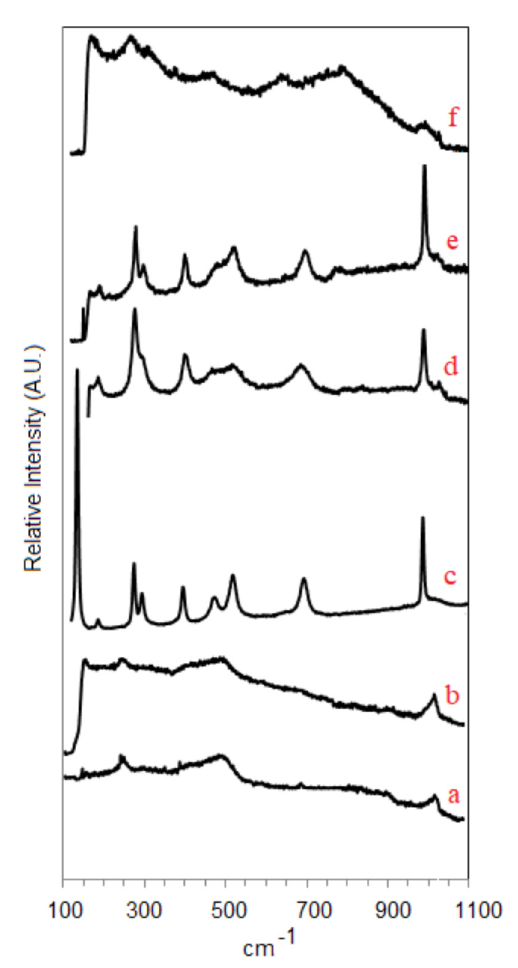
Figure 3. Raman shift: ( a ) 1VOx / S, ( b ) 2VOx / S, ( c ) 5VOx / S, ( d ) VOx / 5ZrOx / S, ( e ) VOx / 10ZrOx / S, and ( f ) VOx / 20ZrOx / S.